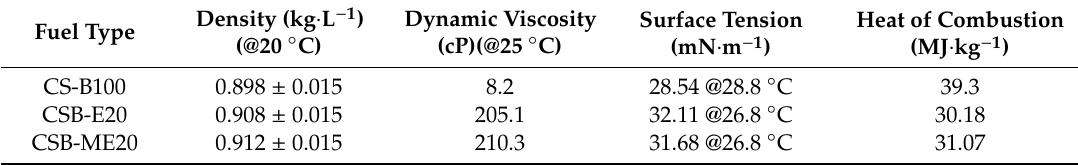
Table 1. Measured physical fuel properties Reproduced from [30], MDPI: 2014.